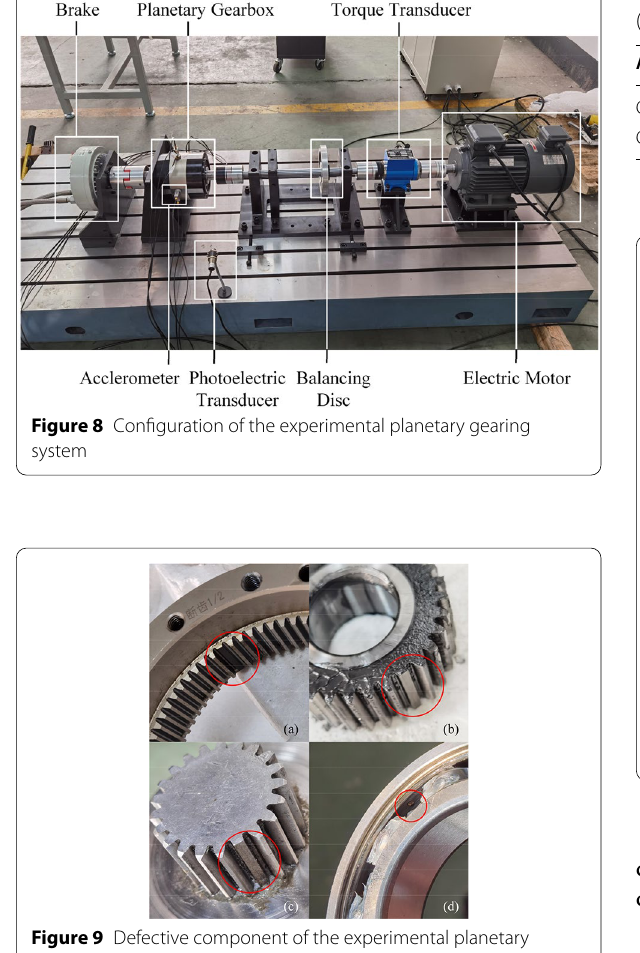
Table 5 Classification accuracy of the CNN based experiment